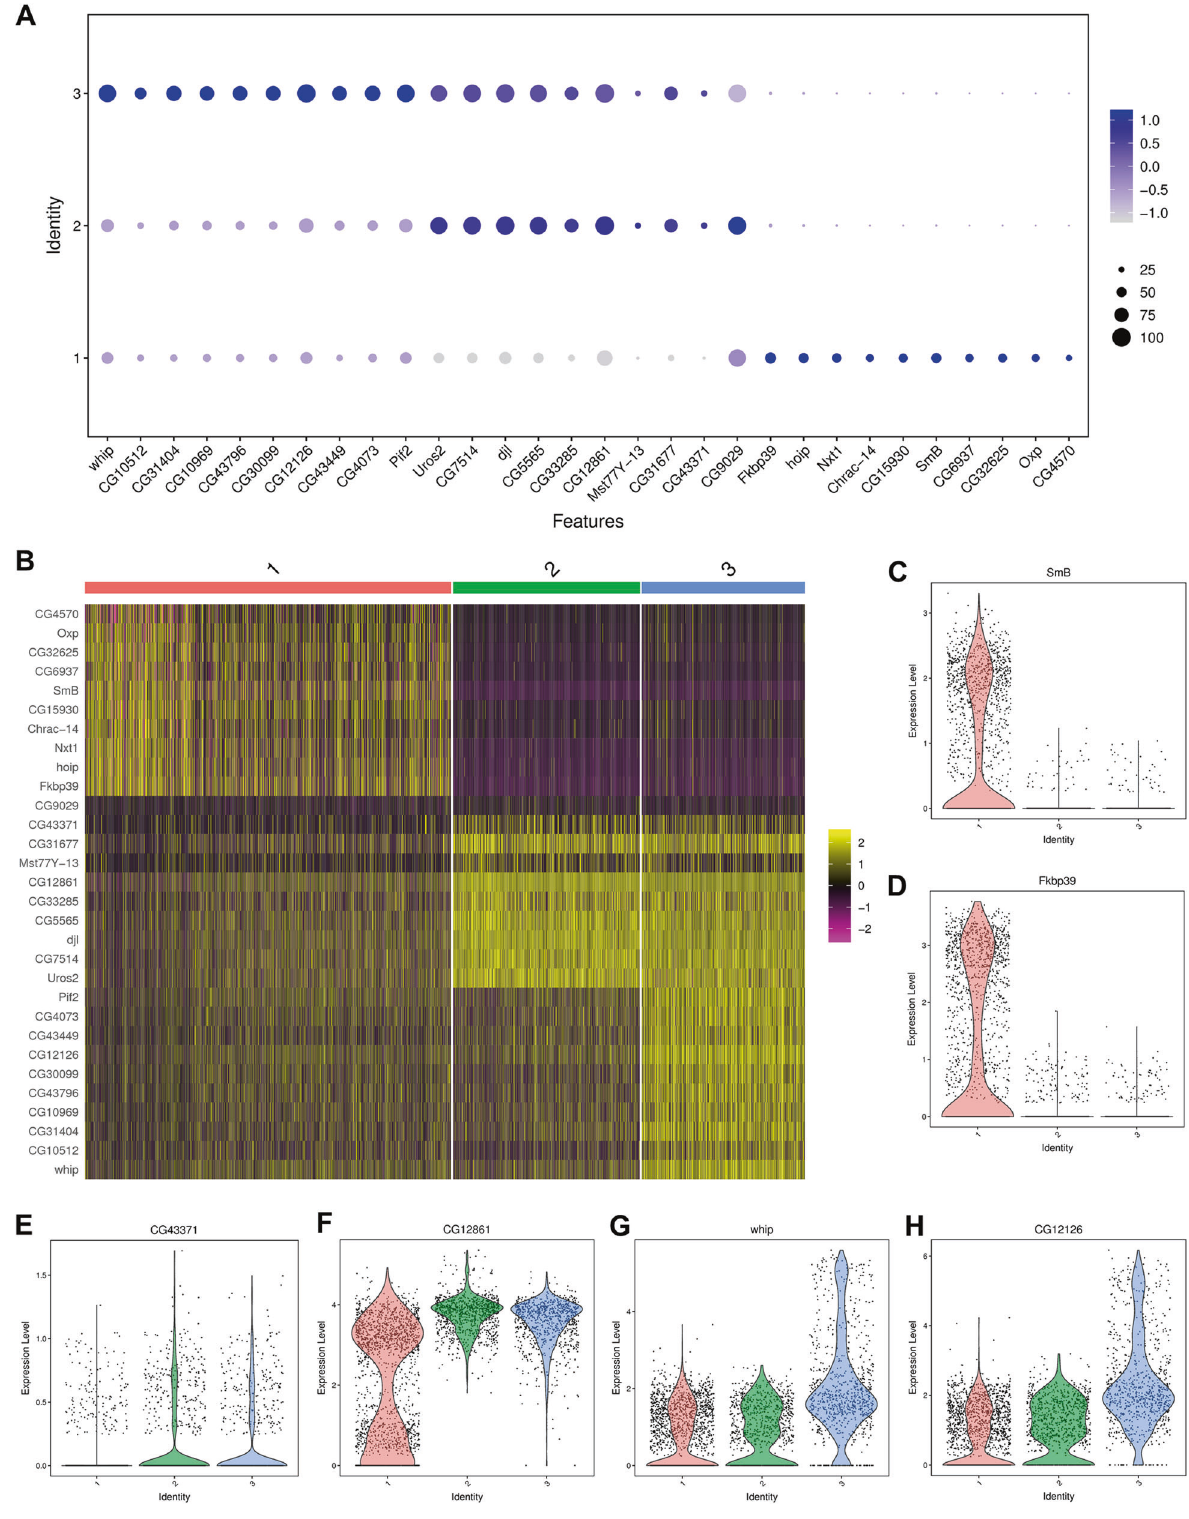
Fig. 7 Characteristic of three novel states during spermatogenesis. A The dot plot view of representative highly expressed genes in each state of germ cell populations. B The heatmap view of representative highly expressed genes in each state of germ cell populations. C The violin plot view of SmB in three states of germ cell populations. D The violin plot view of Fkbp39 in three states of germ cell populations. E The violin plot view of CG43371 in three states of germ cell populations. F The violin plot view of CG12861 in three states of germ cell populations. G The violin plot view of whip in three states of germ cell populations. H The violin plot view of CG12126 in three states of germ cell populations.